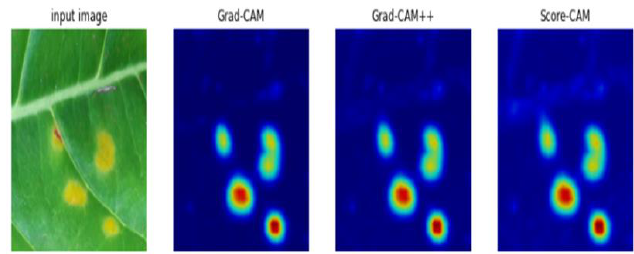
Figure 13. Heatmaps on patch images.